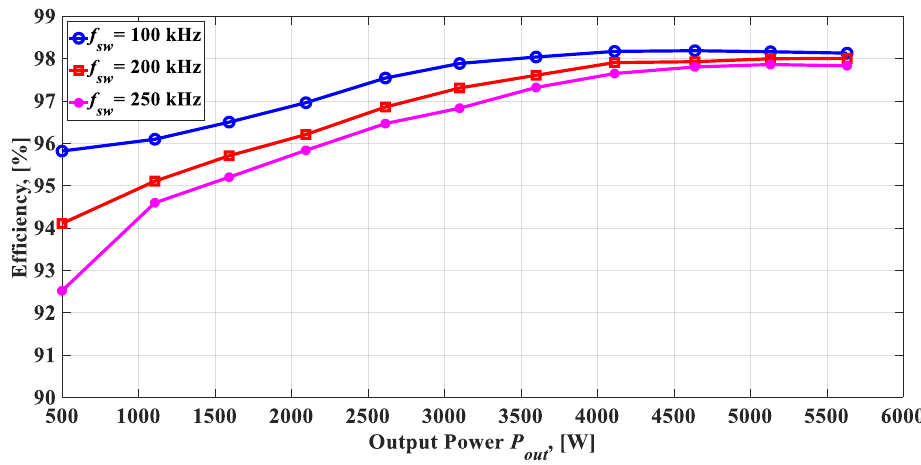
Figure 11. Efficiency comparison of the whole proposed converter at different switching frequencies. The measured power losses are separated into GaN HEMT power loss (e.g., conduc-